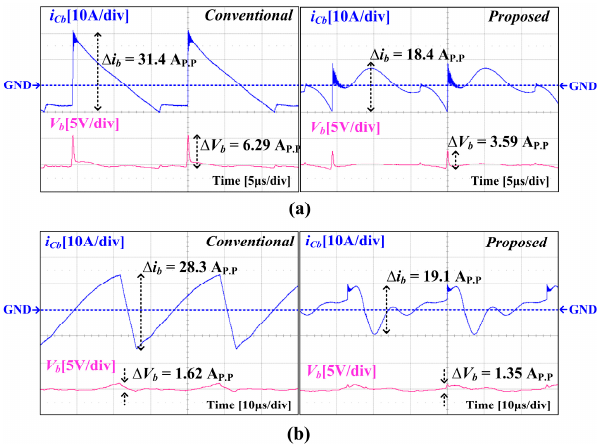
Figure 14. Waveforms of bC i and Δ V b at V a = 48 V, P b = 500 W, and ( a ) V b = 60 V or ( b ) V b = 36 V.